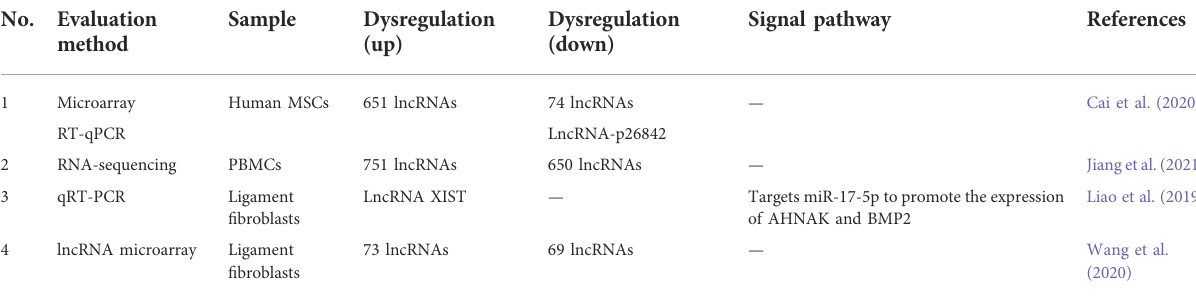
TABLE 1 LncRNAs expression pro fi les in